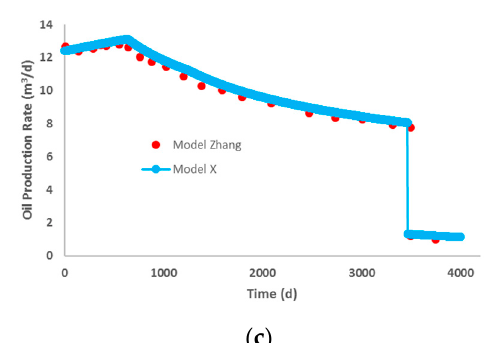
Figure 4. Comparison of our calculated model and Zhang’s model [34] for the daily oil production rate in different permeability layers. Red dots denote Zhang’s model; blue dotted line denotes the calculated model. ( a ) High permeability layer; ( b ) Middle permeability layer; ( c ) Low permeability layer.